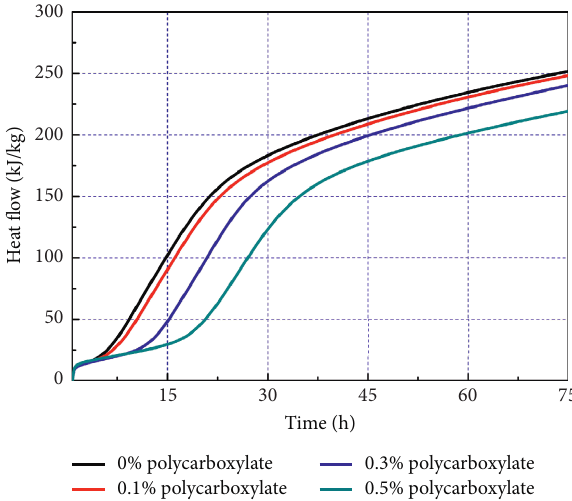
Figure 10: Effect of PCE-2 dosage on hydration heat of cement pastes with 10% metakaolin.